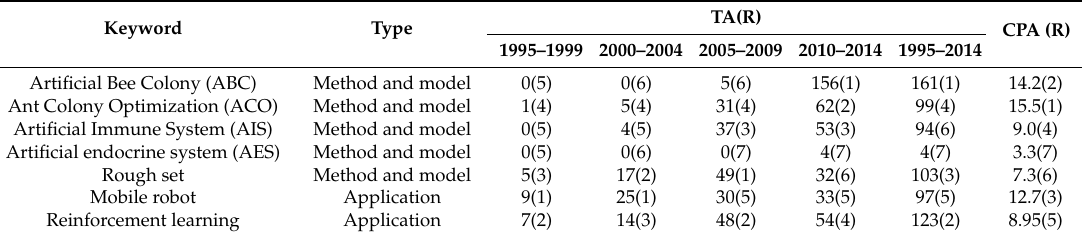
Table 7. New methods, models and applications in artificial intelligence